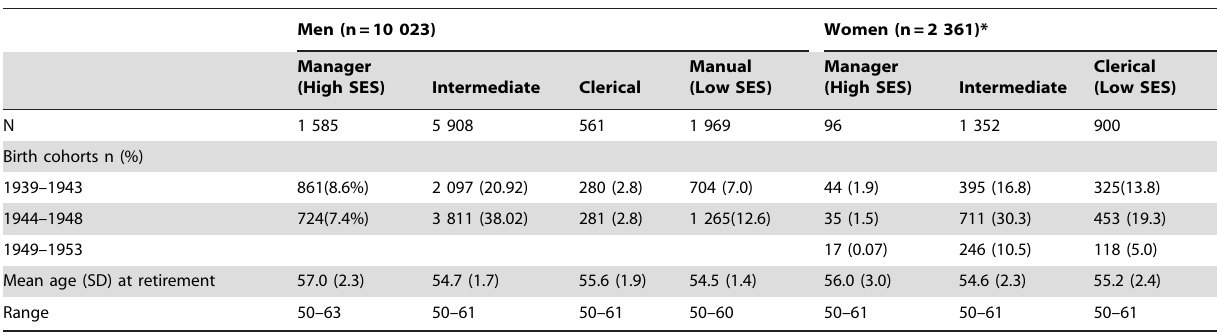
Table 1. Characteristics of the